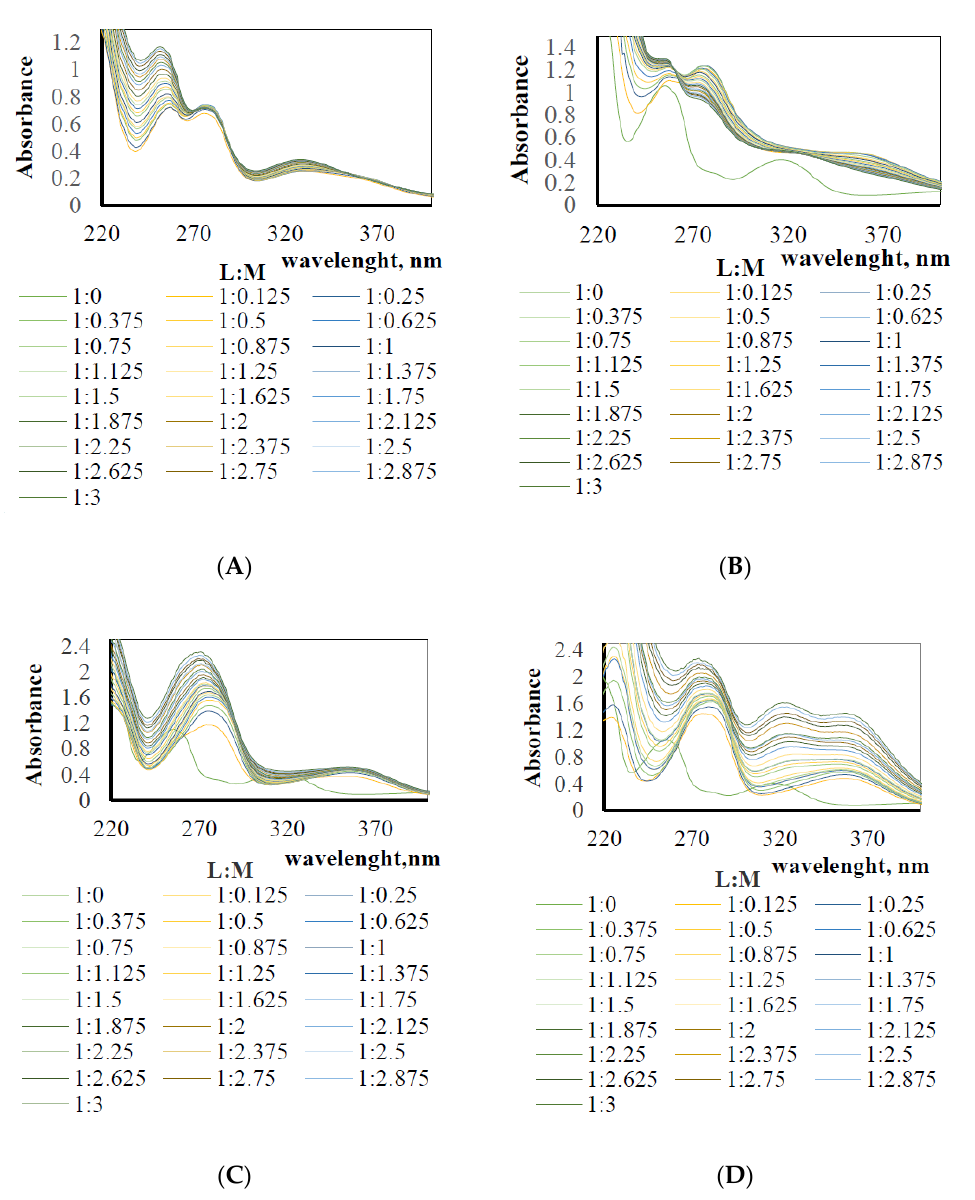
Figure 3. The absorption spectra of the investigated systems (complexes of salen: with ( A ). Pd 2+ , ( B ). Ag + , ( C ). Pt 2+ , and ( D ). Au 3+ ions, respectively.